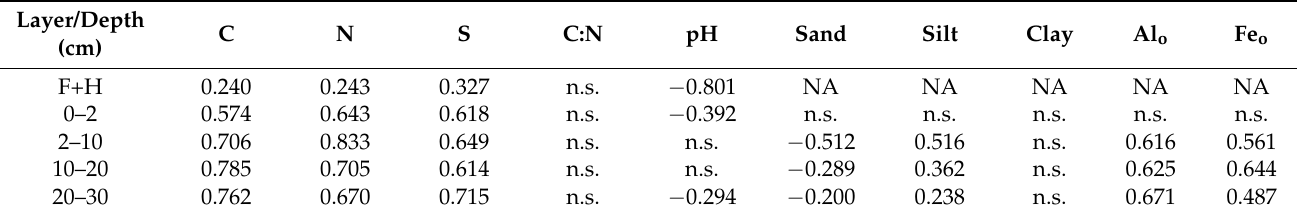
Table 1. Fixed effect coefficients in mixed-effects models of Hg contents at different soil depths, significant at p < 0.001 based on ANOVA using Satterthwaite’s method; n.s., no significant effect; NA, not applicable. The site factor was used as random effect in the